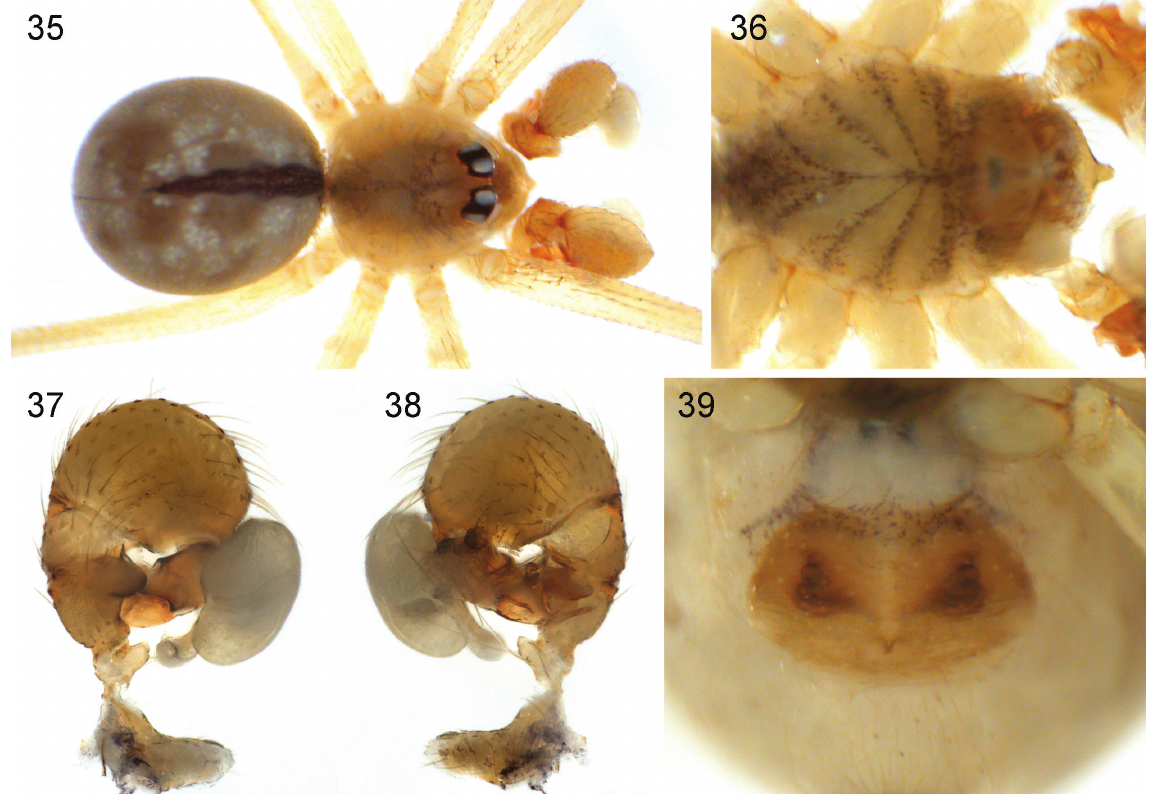
Figs 35-39. Anansus kamwai sp. nov. 35 . ♂, dorsal view. 36 . ♂ sternum, ventral view. 37-38 . Left ♂ palp, prolateral and retrolateral views. 39 . ♀ epigynum, ventral